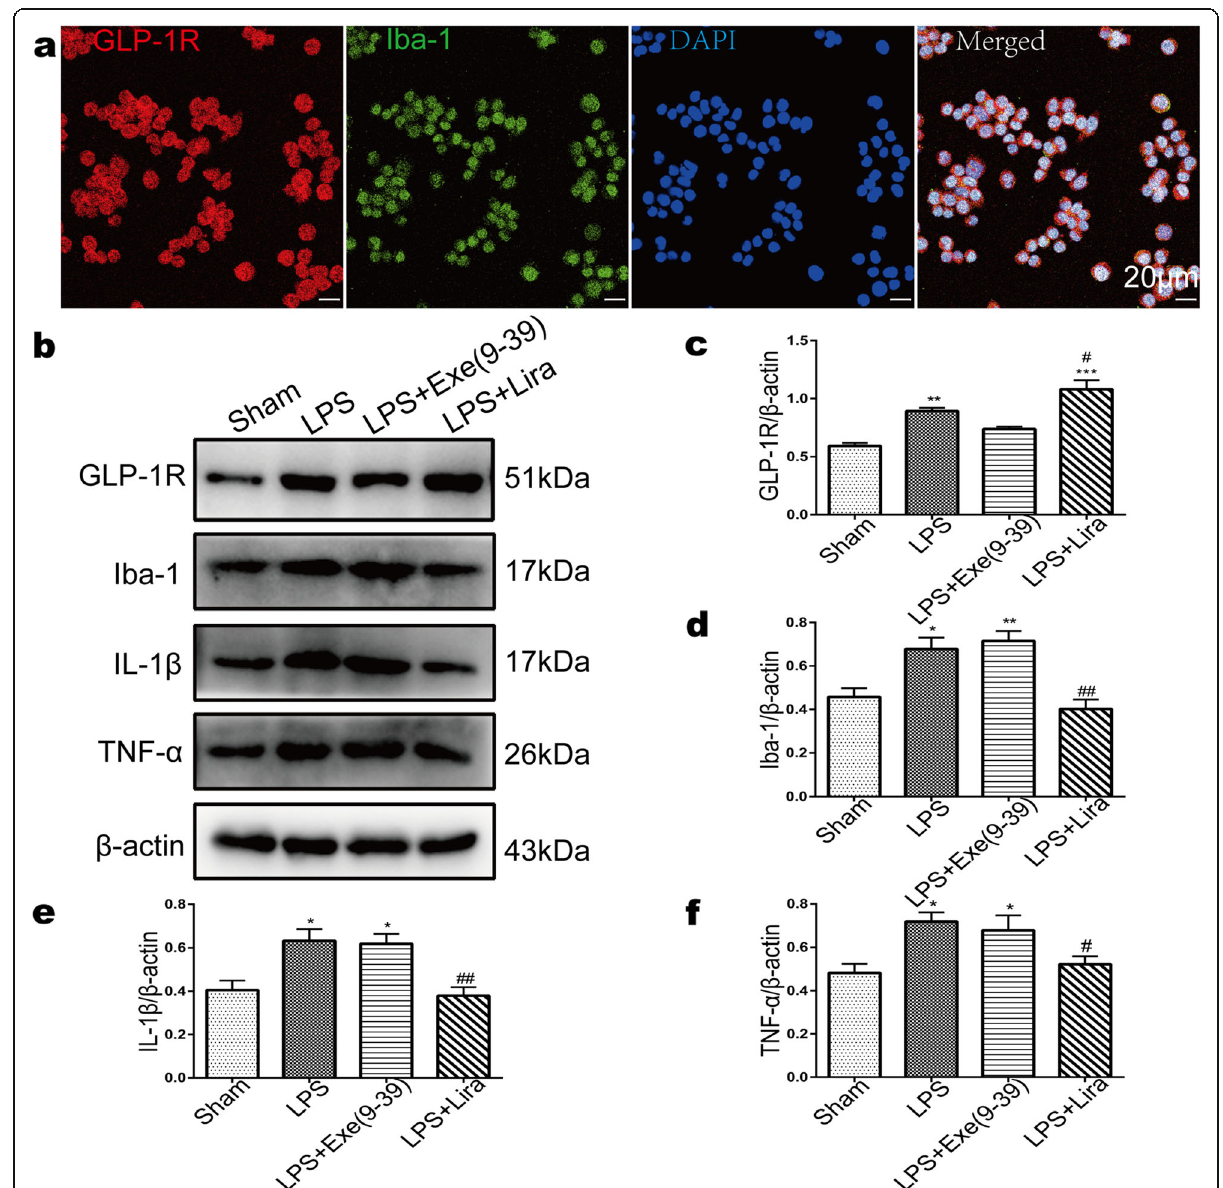
Fig. 7 Activation of GLP-1R inhibited LPS-stimulated BV-2 microglial inflammatory cytokine release. a Double immunofluorescence staining images of GLP-1R with Iba-1 in BV-2 cells. Scale bar: 20 μ m. b Western blots showing the alterations of GLP-1R, Iba-1, IL-1 β and TNF- α protein levels in LPS-triggered BV-2 cells following liraglutide and exendin(9 – 39) incubation. c-f The graphs show the quantification of band intensities, which are presented relative to those of β -actin. Data are presented as mean ± SEM of three independent experiments; * p < 0.05, ** p < 0.01 and *** p < 0.001 vs. sham group; # p < 0.05, ## p < 0.01 vs. LPS